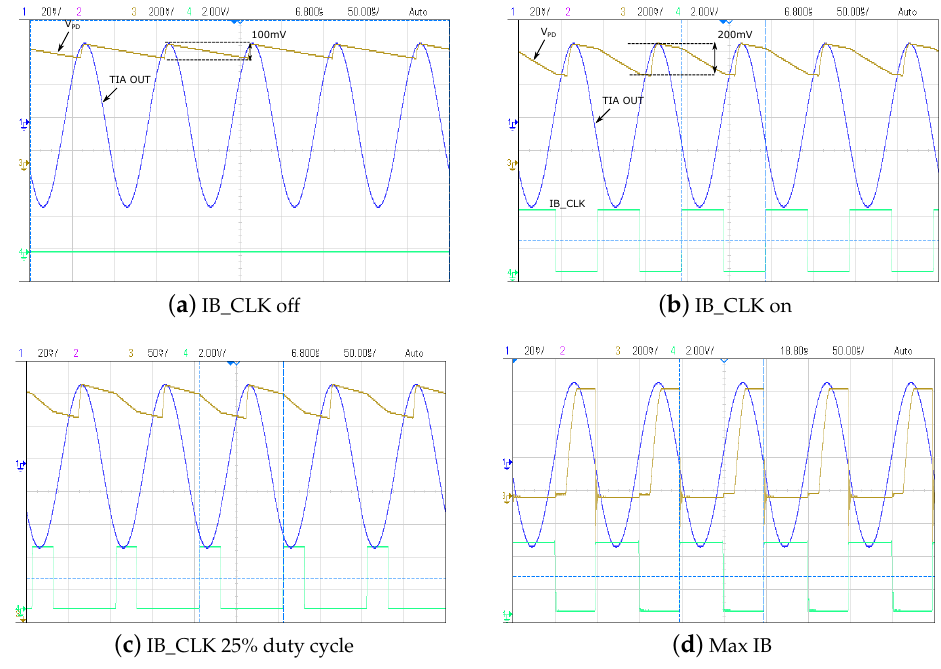
Figure 14. Real-time operation of the peak